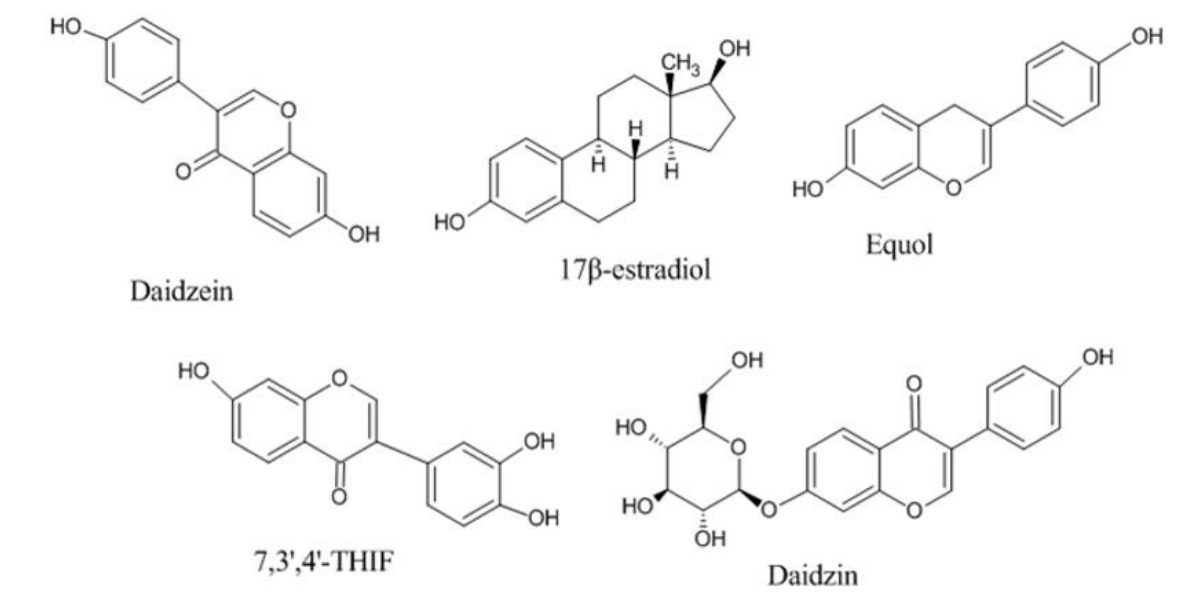
Figure 1. Chemical structures of Daidezin and its various analogs.